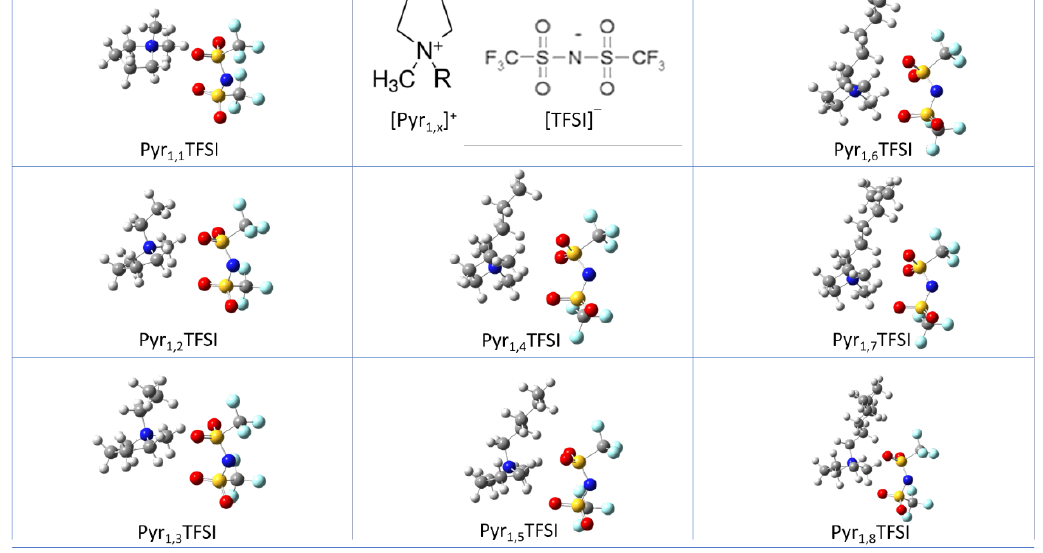
Figure 1. Molecular structures of the studied ionic couples Pyr 1, x TFSI (x = 1–8).